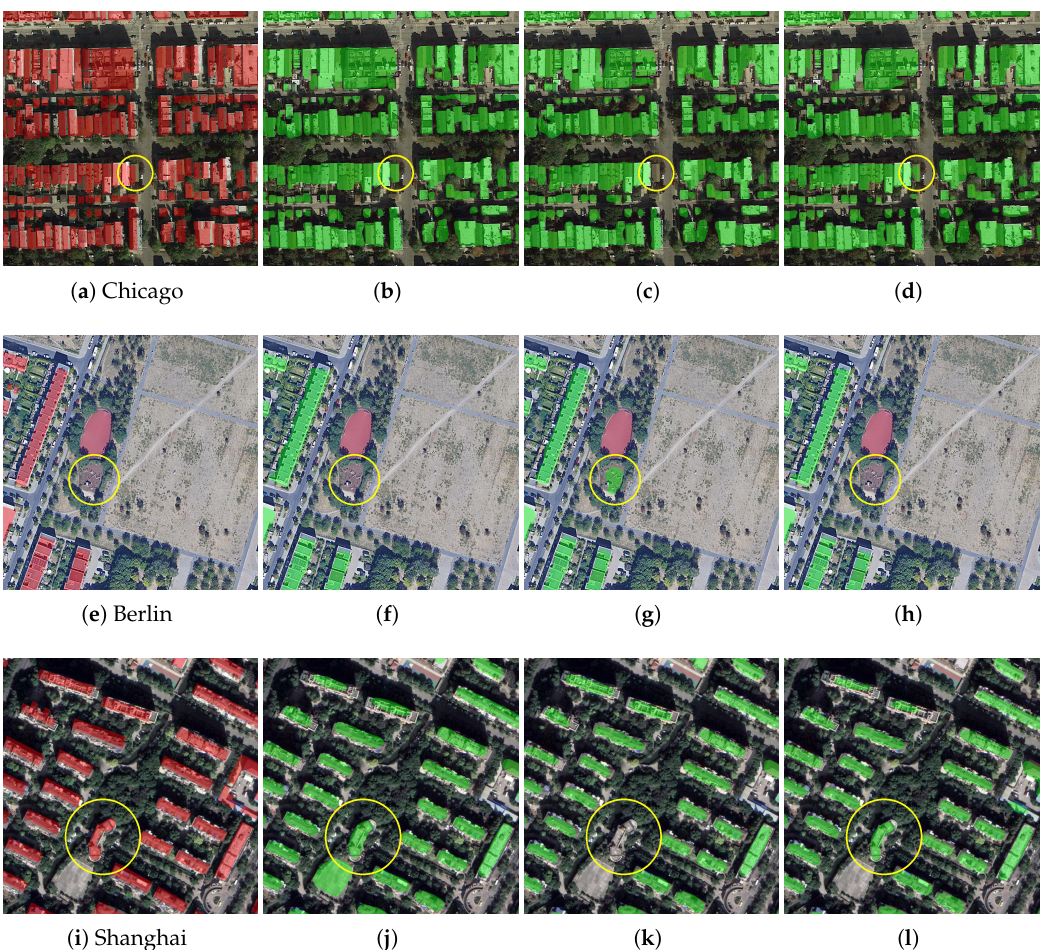
Figure 8. Semantic segmentation results of different models from the cities of Chicago, Berlin, and Shanghai. The figures of ( a , e , i ) colored in red are the ground truth of images, and the figures of ( b , f , j ) colored in green are the prediction of a single model. The figures of ( c , j , k ) are the prediction of end-to-end gradient boosting, and the figures of ( d , h , l ) are the prediction of GeoBoost. Yellow circles highlight some notable discrepancies among different prediction results. Each image in this figure has a size of 1024 ×